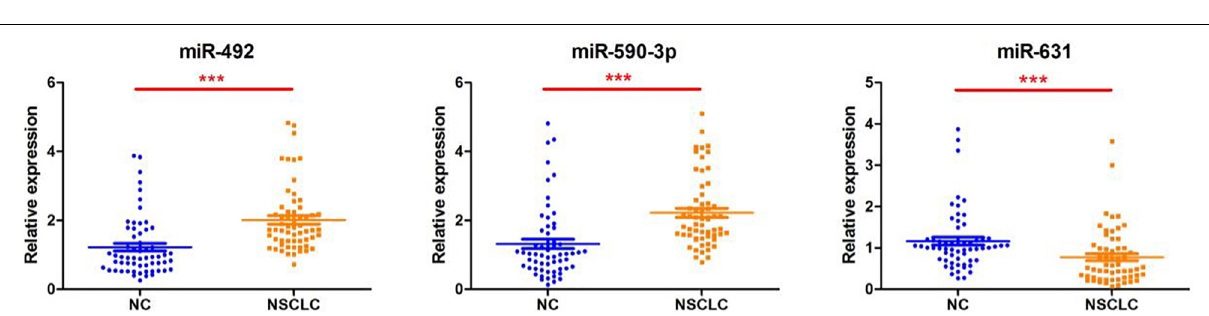
FIGURE 1 | Differentially expressed serum miRNAs in the training set. The miRNA levels of miR185-p, miR-431-5p, miR484, miR-492, miR-590-3p, and miR-631 were detected by RT-PCR assay. Data are presented as mean ± SD. * p < 0.05 vs. NC group, ** p < 0.01 vs. NC group.